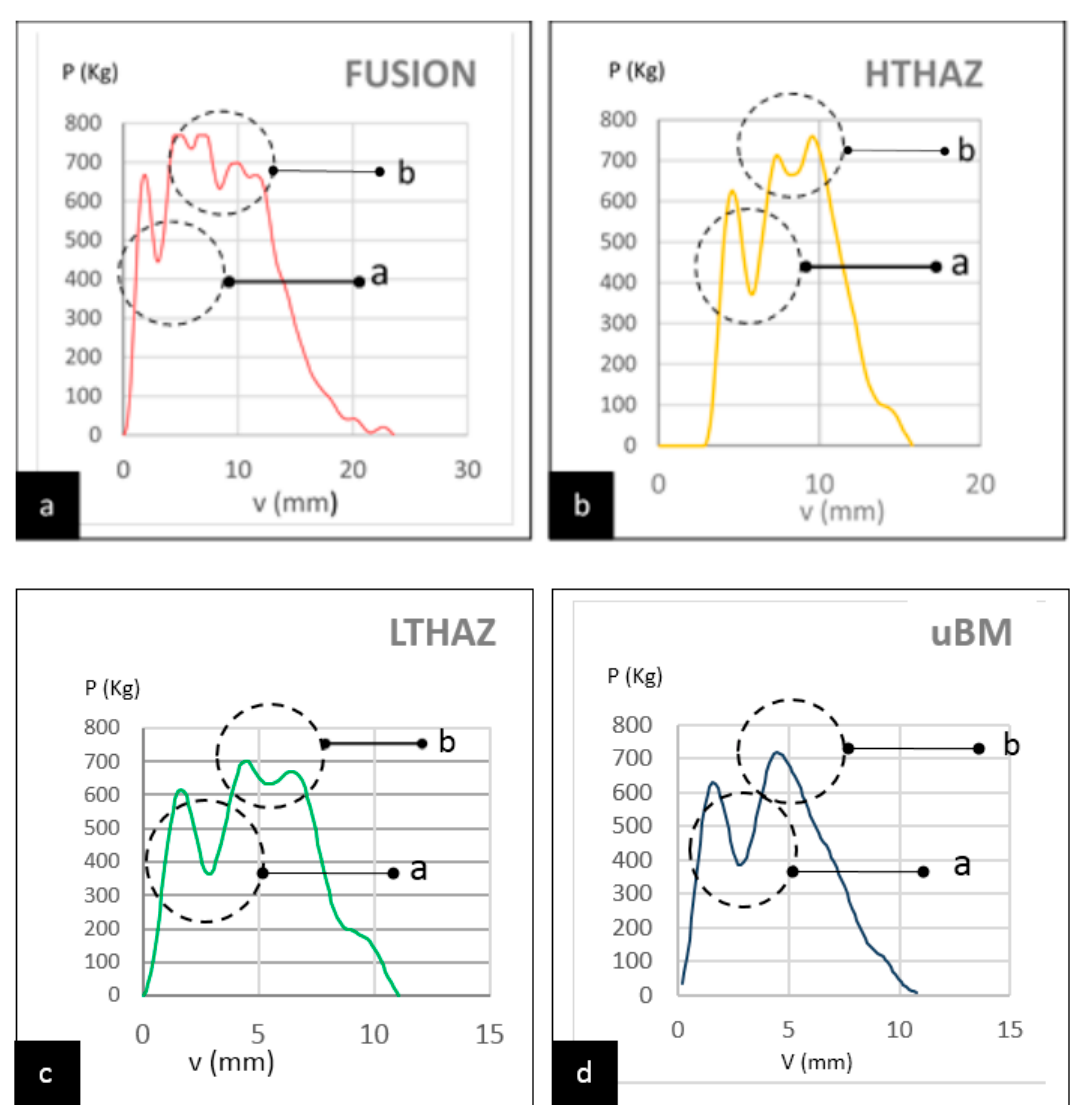
Figure 6. Findings: negative overshoots “a” and number of peaks “b”. ( a ) a negative overshoot “a” and lots of peak “b” in fusion zone (FZ). ( b ) a negative overshoot “a” and moderate number of peak “b” in high temperature heat affected zone (HTHAZ). ( c ) a negative overshoot “a” and moderate number of peak “b” in (LTHAZ). ( d ) a negative overshoot “a” and a peak “b” in unaffected Base Metal (UBM) zone.